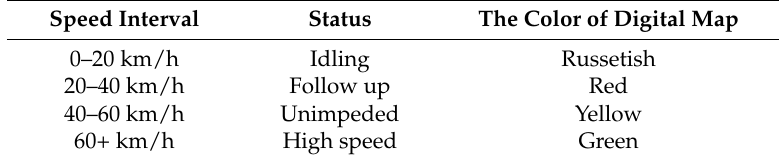
Table 4. The correspondences between the speed interval and traffic conditions prediction.